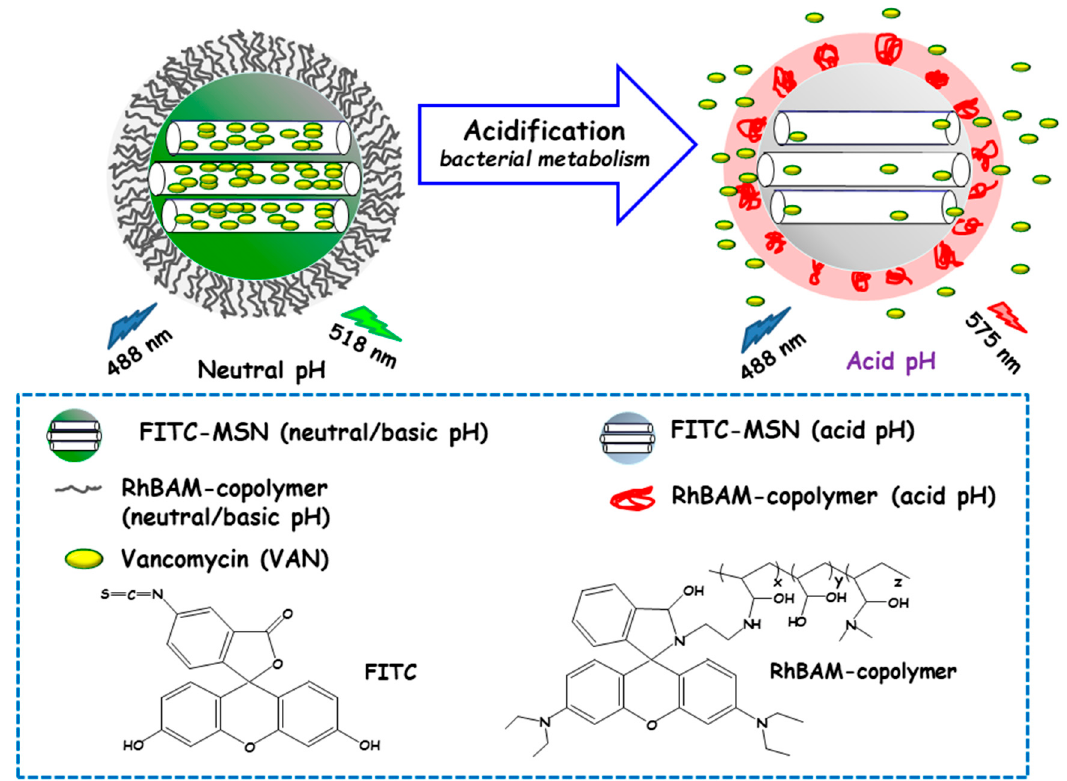
Figure 6. Schematic representation of the operating mechanism of pH-responsive antimicrobial nanosystems consisting of fluorescein isothiocyanate (FITC)-derivatized MSNs loaded with vancomycin and capped with a pH-sensitive hydrogel (RhBAM-modified PNIPAAm copolymer) for the e ffi cient killing of E. coli . Adapted from ref. [84]. FITC: fluorescein-isotiocianate, RhBAM: Rhodamine B-derivative, PNIPAAm: poly (N-isopropyl acrylamide-co-acrylic acid). At the physiological pH (neutral) the copolymer on MSNs is in swollen-state, whereas it shrinks under environment acidification due to bacterial metabolism, allowing cargo release. The nanosystem operates as a radiometric fluorescence probe. Upon irradiation at 488 nm it shows a strong emission at 518 nm at neutral pH, whereas at acidic pH the fluorescence emission occurs at 575